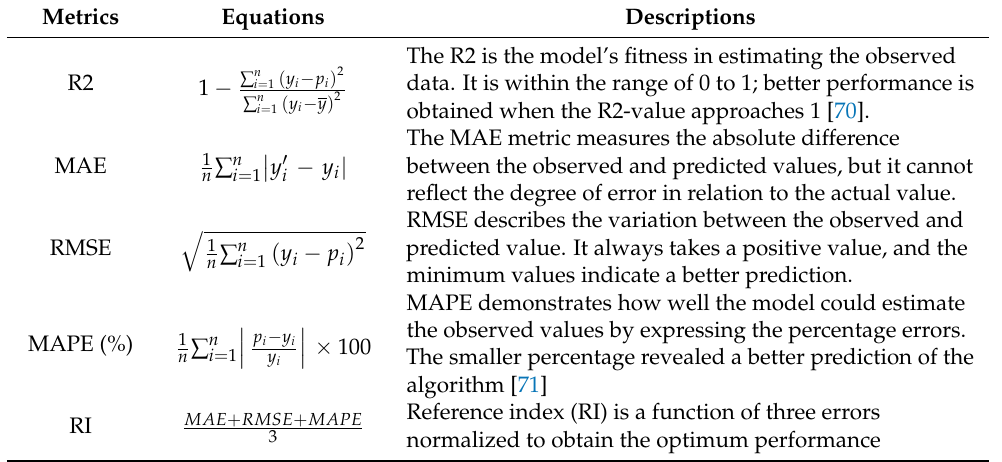
Table 3. Evaluation